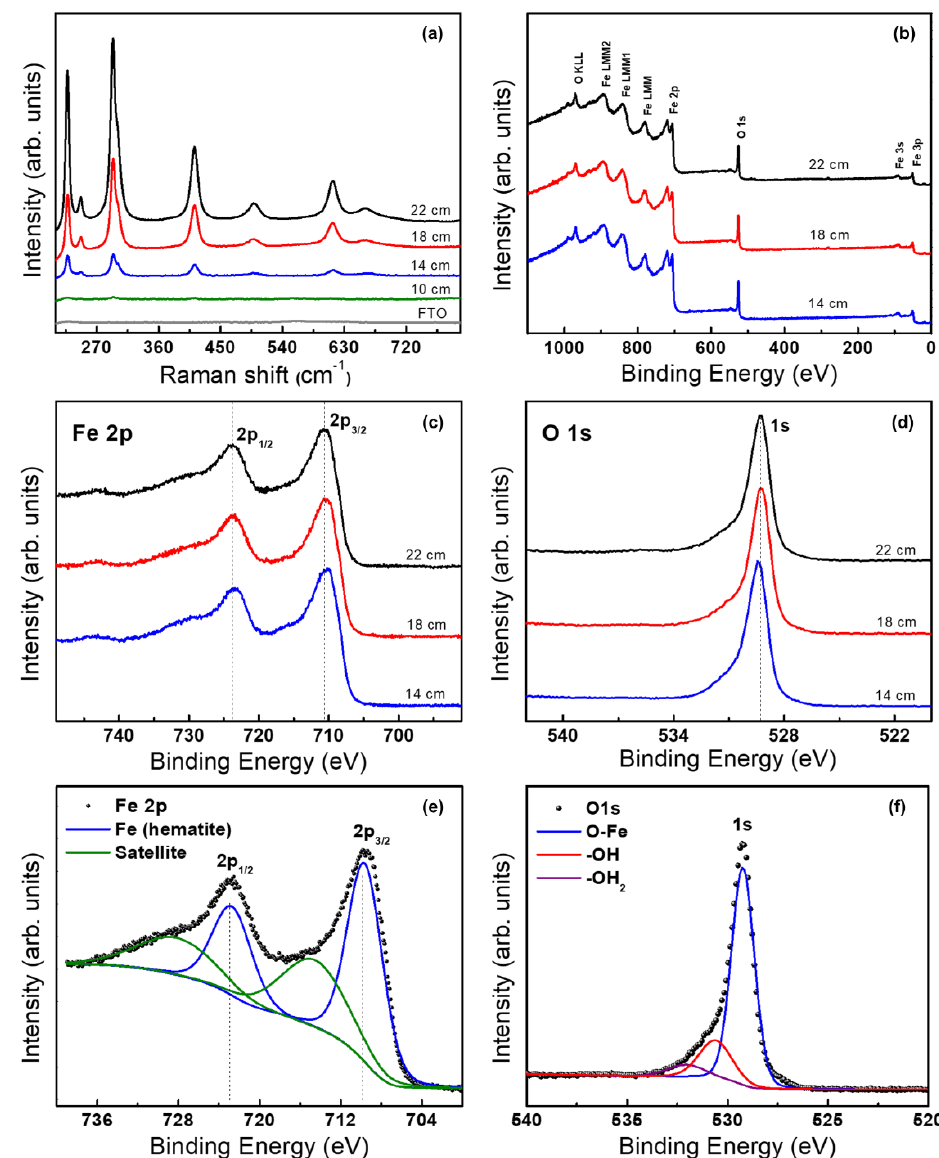
Figure 3. ( a ) Raman spectra of FTO and electrodes prepared at 10, 14, 18, and 22 cm. XPS spectra of hematite films grown at 14, 18 and 22 cm: ( b ) survey, ( c , d ) are the high-resolution measurements of signals Fe2p and O1s, respectively. ( e , f ) are the Fe2p and O1s signals of the film grown at 18 cm, fitted using the software Multipack.